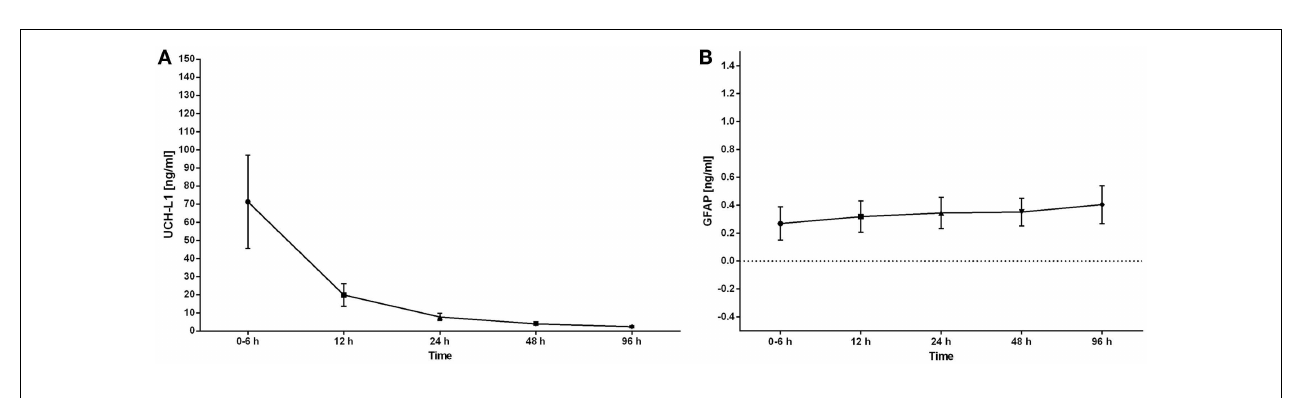
of UCH-L1 decreased rapidly over the initial 24h with the highest concentrations obtained at 0–6h (A) .The serum concentrations of GFAP increased over the 96h of sampling (B)